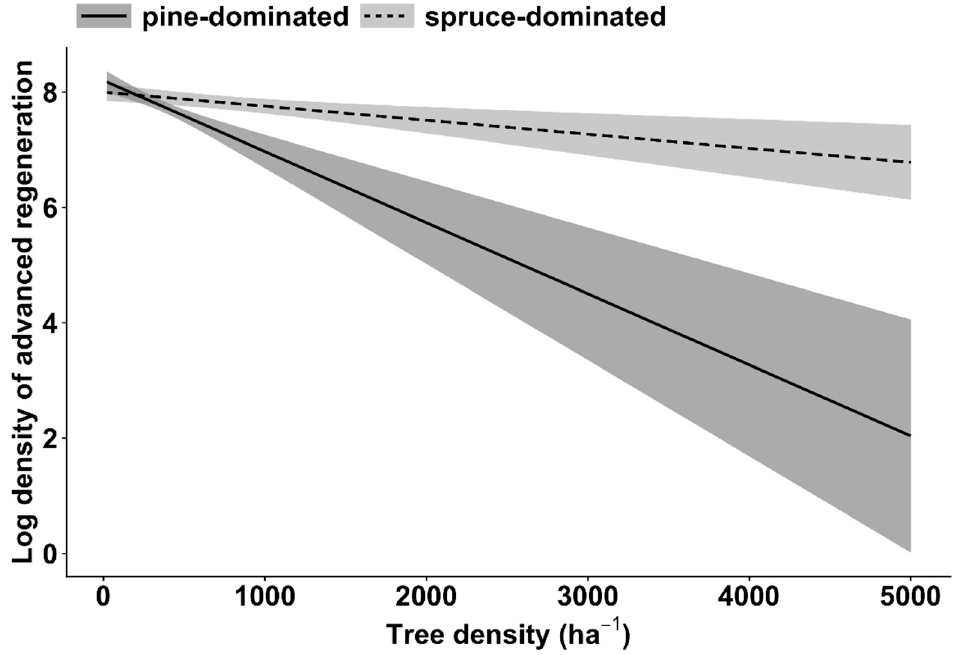
Figure 8. The influence of tree density on the density of advance regeneration in Scots pine and Norway spruce-dominated stands. The grey area represents a ±95% confidence interval.